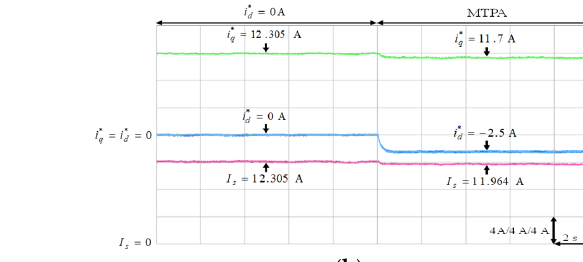
Figure 11. Experimental results of MTPA control at 500 rpm with 6 Nm: ( a ) mechanical speed command, speed and speed error; ( b ) q -axis current command, d -axis current command and stator current.